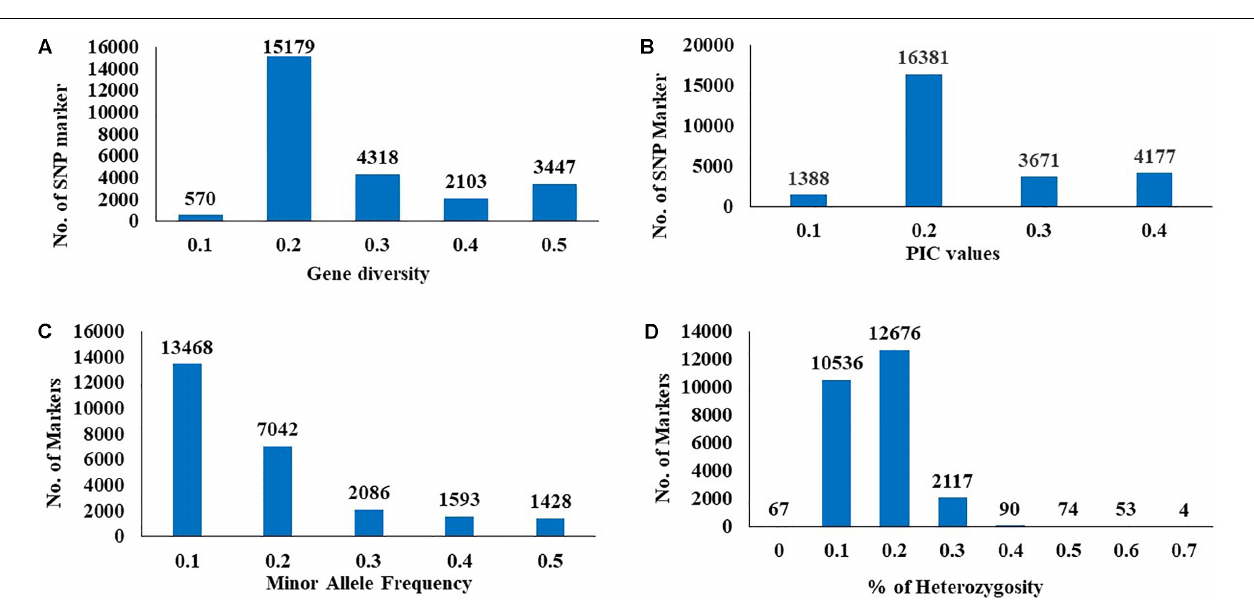
subpopulations. So, the Fst value were 0.107, 0,153, and 0.234 for G2, G3, and